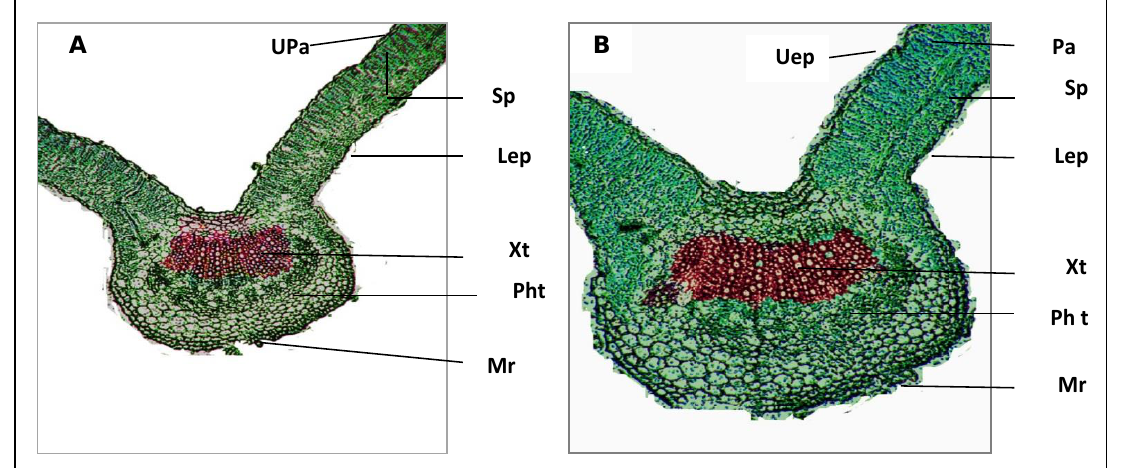
Figure 4. Transverse section through the first leaflet blade of the compound leaf developed on the median portion of the main stem of broad bean plant as affected by exogenous application with FeNPs (T1). Untreated plant ( A –CT) and plant treated with 6 nm FeNPs ( B –T1) ( × 100). Uep = Upper epidermis; Pa = palisade tissue; Sp = Spongy tissue; Lep = lower epidermis; Xt = xylem tissue; Pht = phloem tissue; Mr = midrib region.